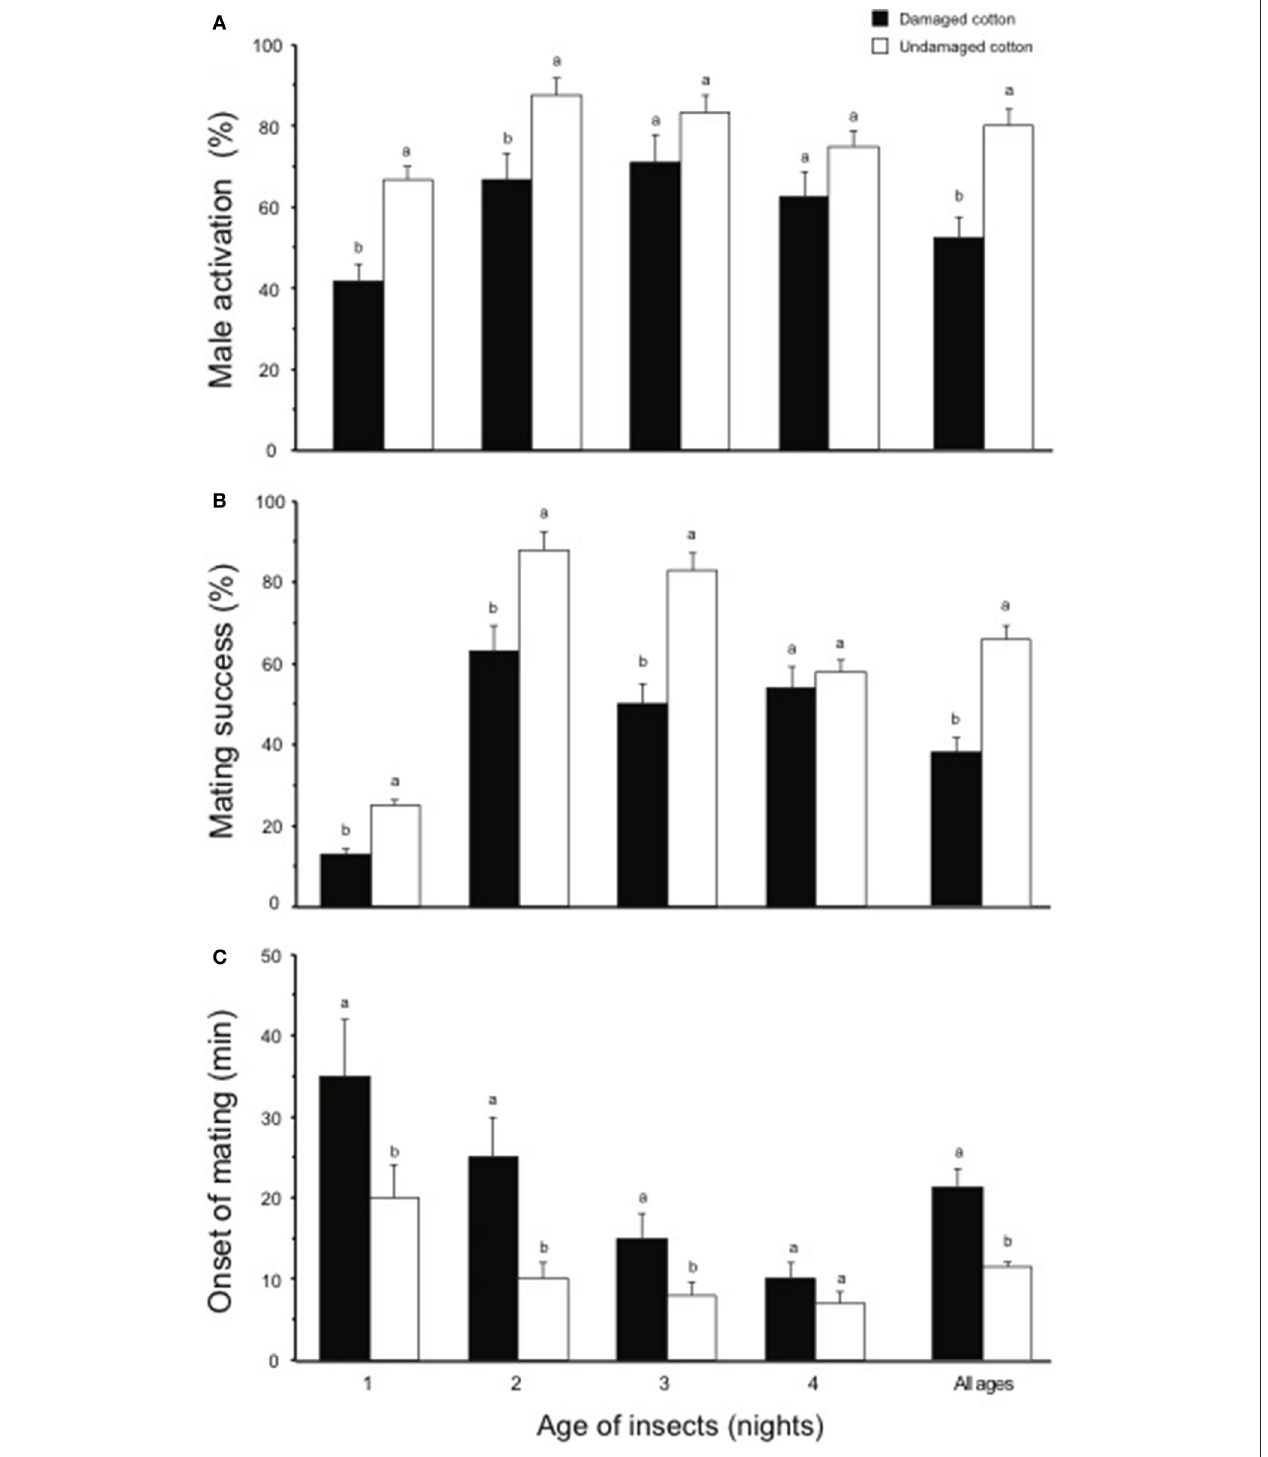
FIGURE 5 | Percentage of male activation (A), mating success (B), and mean onset time of mating (C) in S. littoralis in the presence of damaged and undamaged cotton plants. Male and female moths were allowed to mate in the presence of either damaged cotton plants (black bars) or undamaged cotton plants (white bars), over a period of four consecutive nights. Standard errors are represented on each bar. Chi square test was used for statistical analysis. Different letters within the bars of each age show significant effect ( P < 0.05, or 0.01 or 0.001).